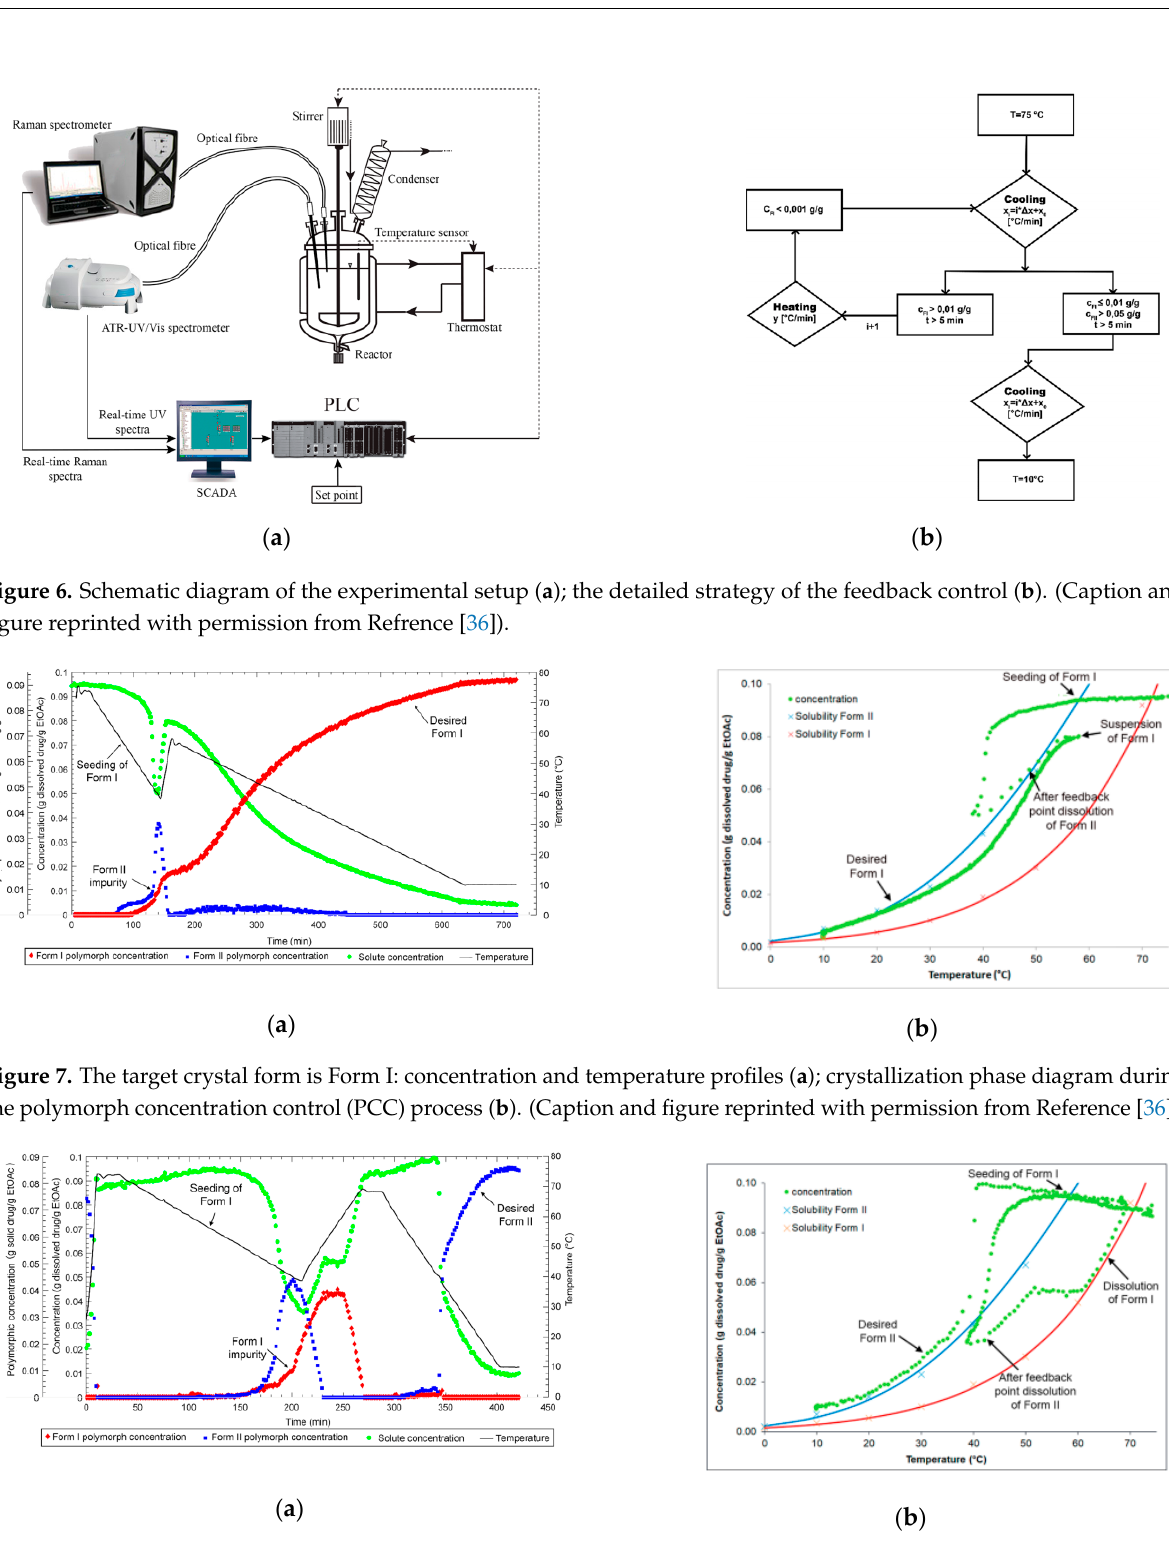
Figure 8. The target crystal form is Form II: concentration and temperature profiles ( a ); crystallization phase diagram during the PCC process ( b ). (Caption and figure reprinted with permission from Reference [36]).